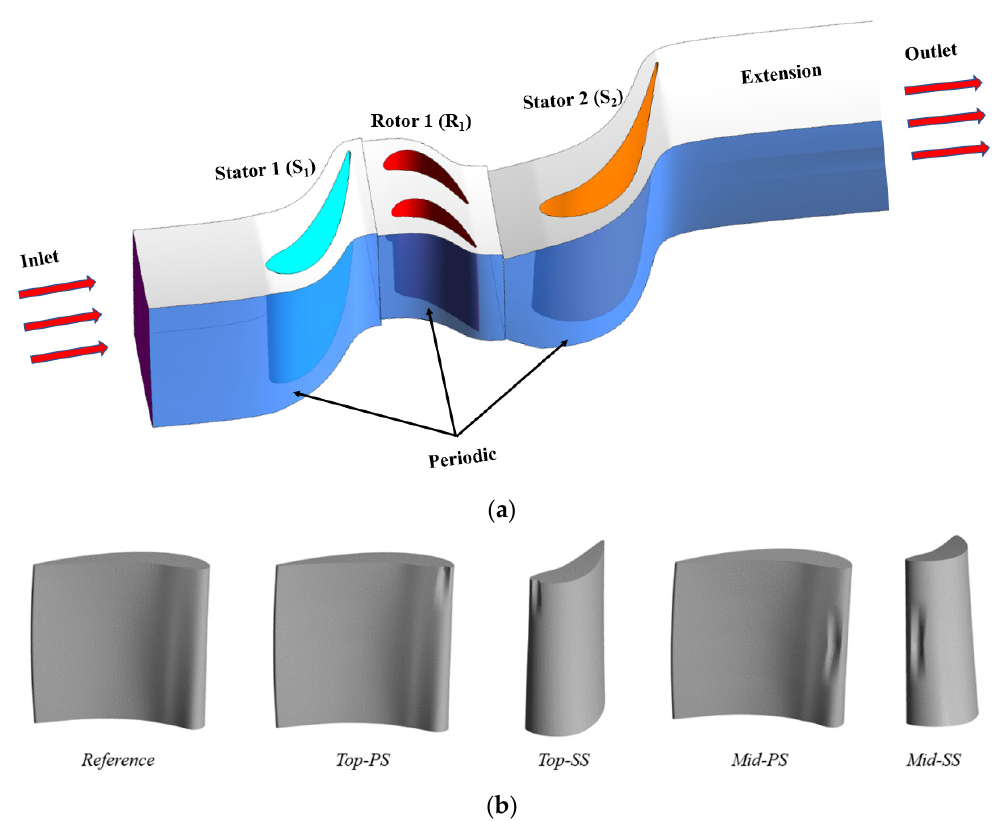
Figure 1. ( a ) Computational domain used for this study; ( b ) Damaged rotor blade after modification; Top and Mid denote the top and middle regions of the blade, respectively. PS and SS denote the pressure-side and suction-side damage, respectively.